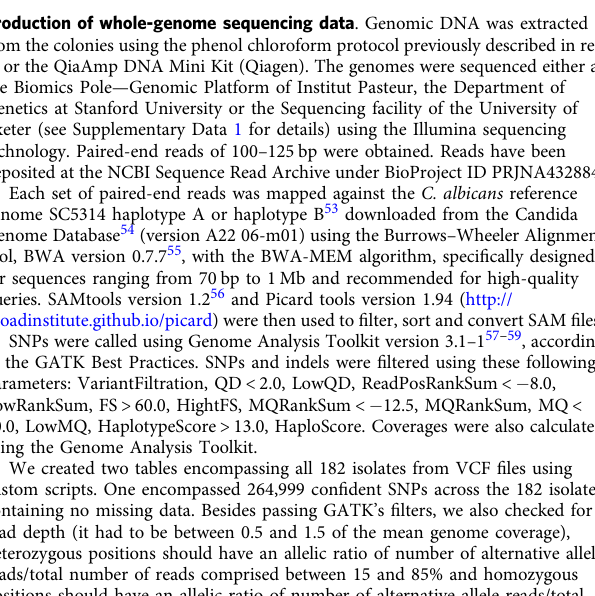
Fig. 5 Strains of cluster 13 grow less well than other strains of C. albicans in different media at different temperatures. Violin plots of growth size scores performed using Iris by grouping isolates by clusters (only the most represented clusters are shown, i.e., those with >10 individuals: clusters 1, 2, 3, 4, 11 and 13) on vaginal-simulative medium (VSM) and YPD; For saliva simulative medium (SSM), we calculated colony size as mean of two perpendicular measures of diameters using ImageJ. Horizontal lines in the boxplots represent the median, vertical ones the length between upper and lower quartiles. Dots represent the outlier values. Some strains showed very poor growth on VSM, preventing measurement of colony size. These strains were not included in the fi gure. All experiments were performed in duplicate. In all conditions (different media and different temperatures), cluster 13 isolates are signi fi cantly less fi t than other strains of C. albicans (ANOVA analyses followed by post-hoc comparisons using TukeyHSD tests (see Supplementary Data 5)). VSM: vaginal-simulative medium, SSM: saliva-simulative medium, YPD: yeast peptone dextrose